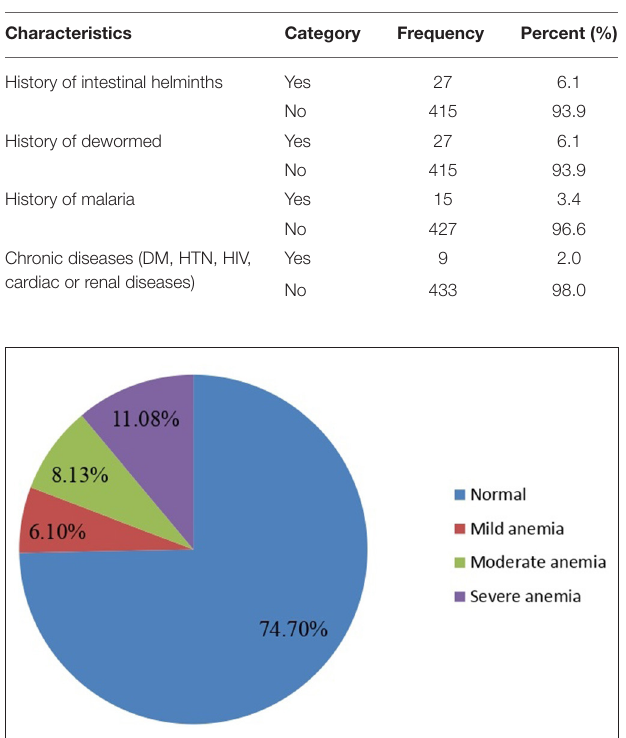
Disease and Infection Characteristics In terms of disease and infection history, 15 (3.4%), 9 (2.0%), and 27 (6.1%) pregnant women had malaria, chronic disease (diabetes mellitus, hypertension, HIV, cardiac or renal diseases), and intestinal helminths, respectively. In addition, 27 (6.1%) of the participants were dewormed ( Table 5